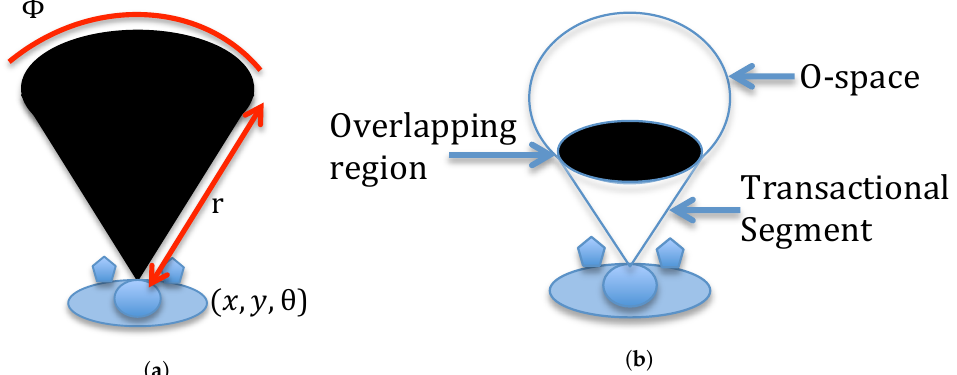
Figure 6. ( a ) The person and their transactional segment. ( b ) The circle is the O-space and the black shaded region indicates the overlap (mapping) of person’s transactional segment with the